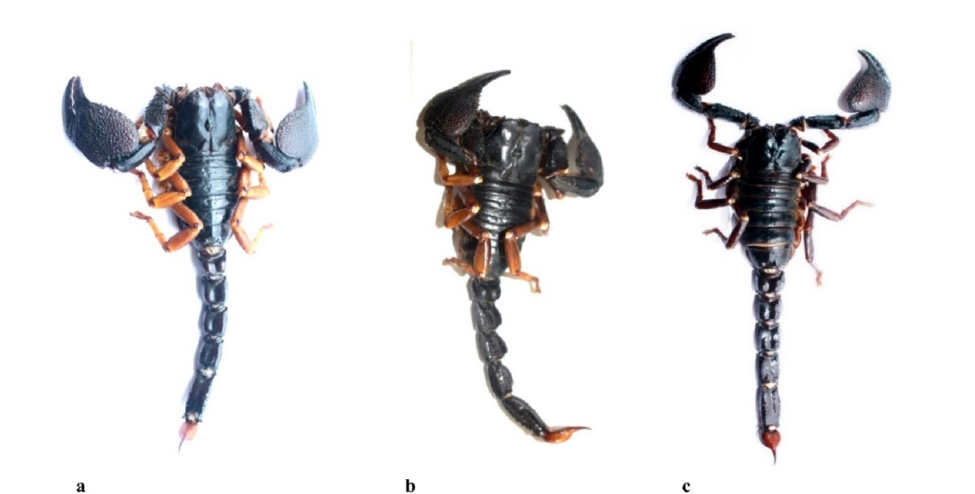
Figure 1. Asian forest scorpions of Telangana State, India [a. Chersonesometrus fulvipes (C.L.